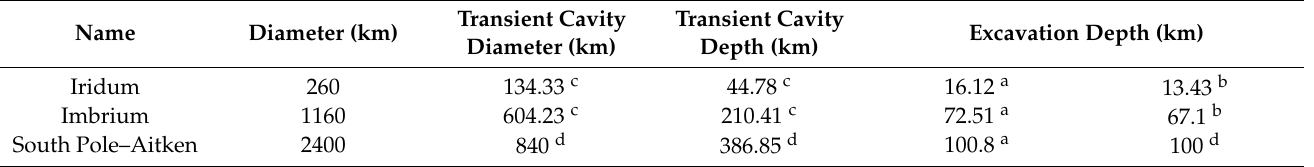
Table 2. Impact basins